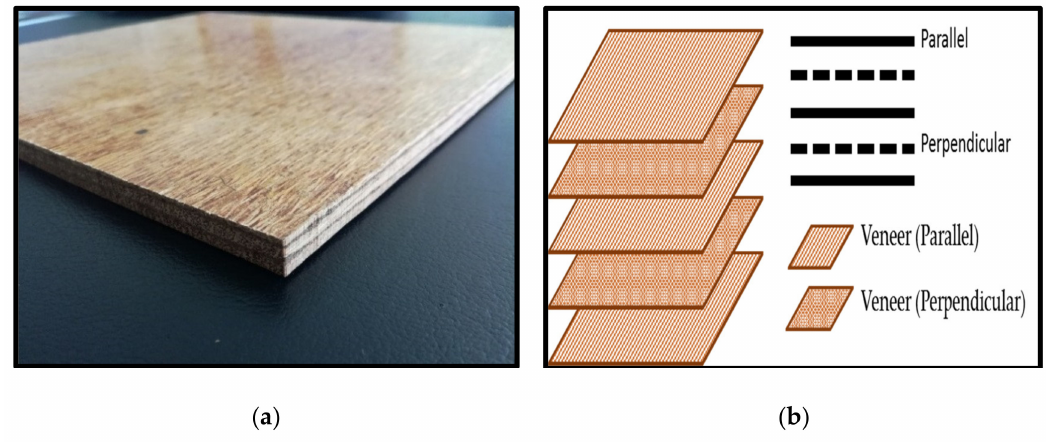
Figure 1. Schematic layering pattern of plywood composites. ( a ) Plywood composites and ( b ) The layering